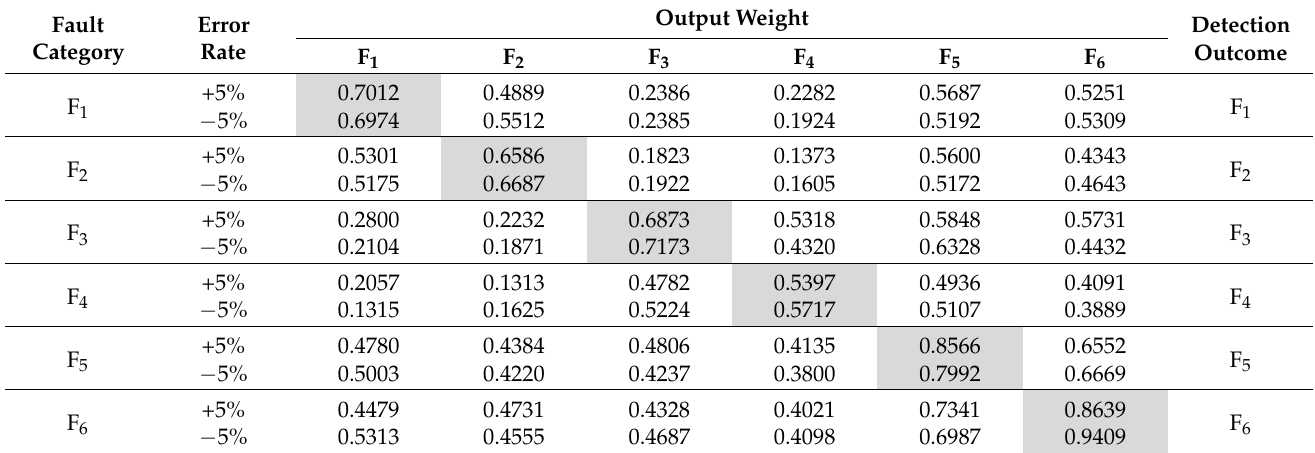
Table 9. Detection outcomes of the inverter at 85 Hz with a ± 5% error margin.